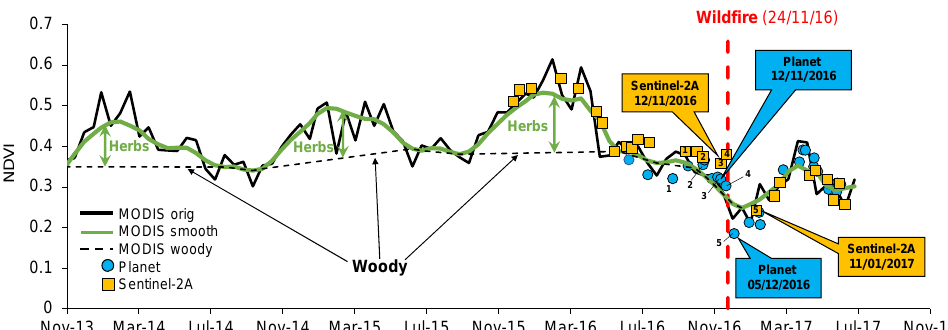
Figure 2. Time series of NDVI from 250-m MODIS, 10-m Sentinel-2A and the 3-m Planet Scope Ortho Scene (a constant value of 0.16 was added to the Planet-derived NDVI time series—see main text).